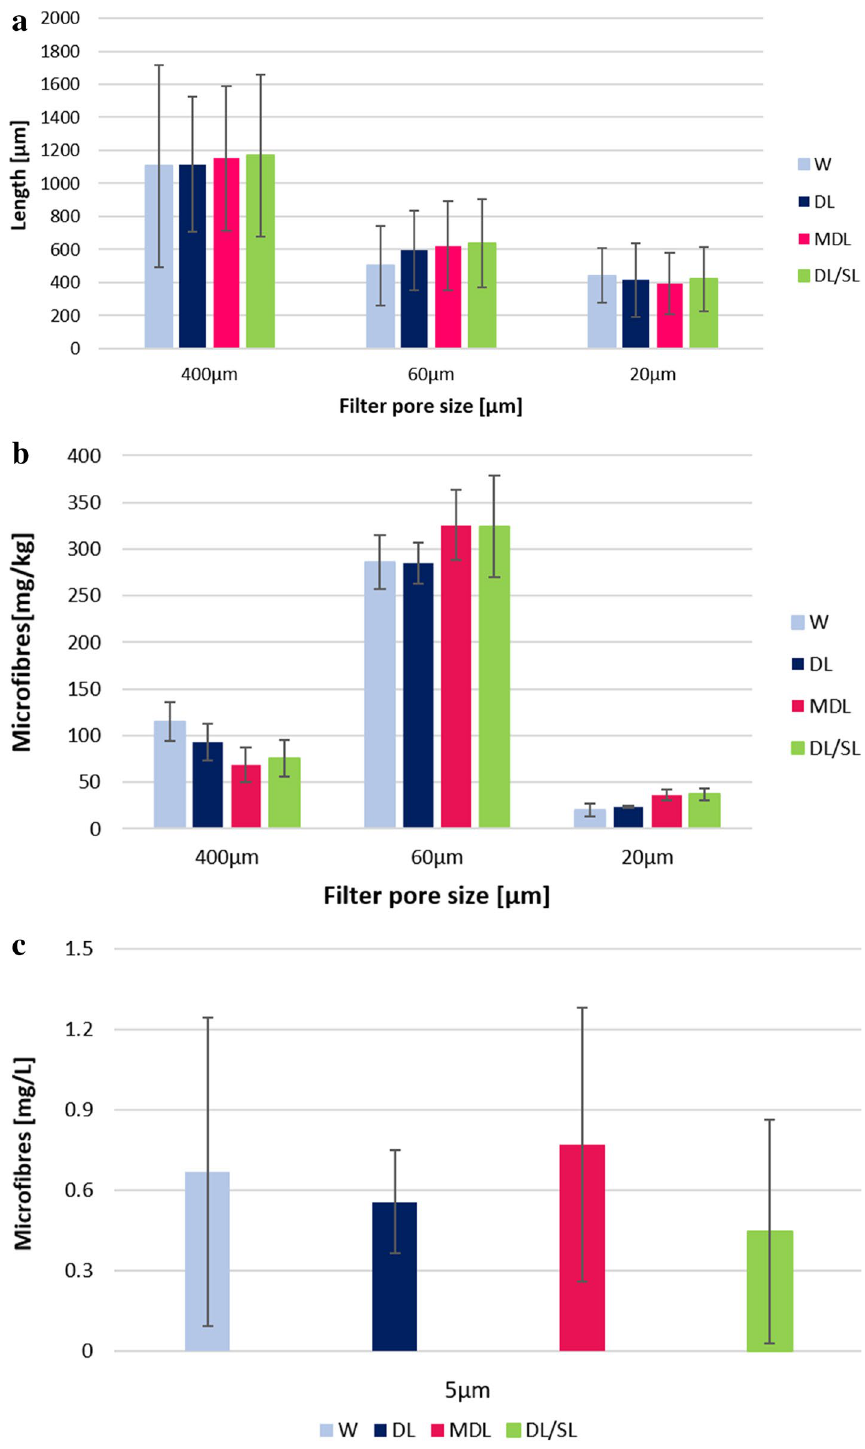
Figure 4. ( a ) Lengths of microfibres recovered on 400 μm, 60 μm,20 μm and 5 μm pore size filters (n = 30); ( b ) amount of microfibres (mg/kg) recovered on 400 μm, 60 μm and 20 μm pore size filters (n = 3); ( c ) microfibres recovered on 5 μm pore size filters (expressed in mg/L ± SD, n =